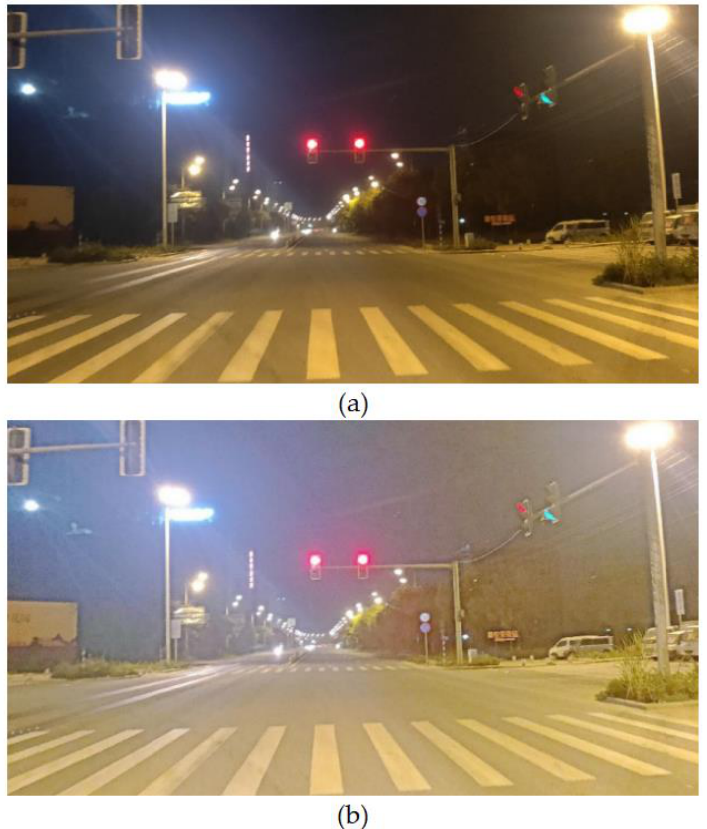
Figure 15. The original image ( a ) and the image processed by the low-light enhancement algorithm ( b ).